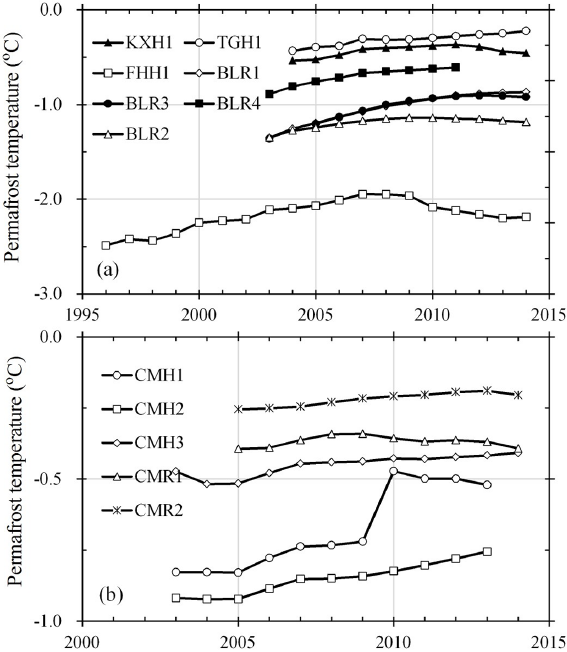
Figure 7. Permafrost temperature at 10m depth beneath embank- ment surface in alpine meadow (a) and alpine steppe (b)